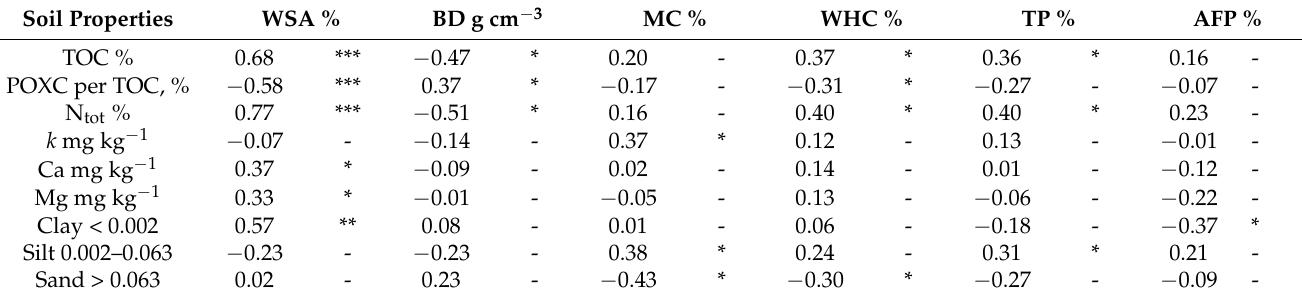
Table 7. Pearson’s correlation coefficients (r) between soil physical and chemical properties and texture; n =